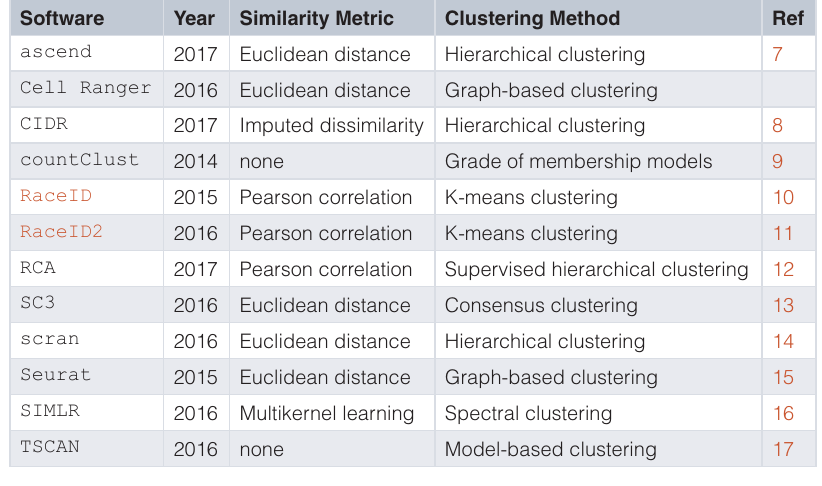
Table 1. Overview of the clustering tools included in this study, and several characteristics